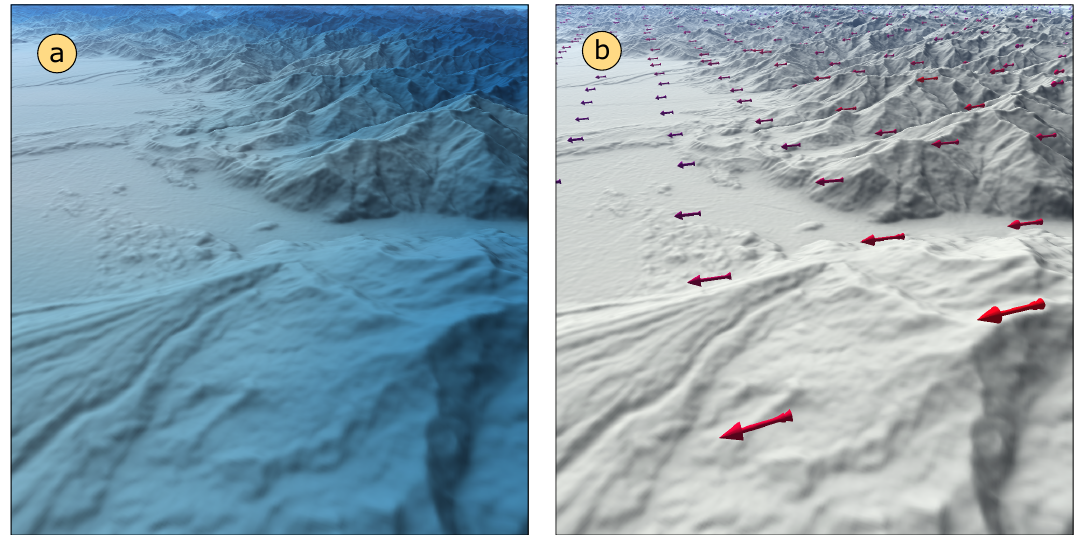
Figure 7. Visualizing data together with terrain. ( a ) shows relative humidity encoded into the color of the surface (light blue means low humidity, dark blue means high humidity); ( b ) shows wind glyphs, encoding wind direction and strength. The direction is given by the arrow head and the strength is encoded by the length of the arrow and a continuous color scale, ranging from blue (light wind) to red (high